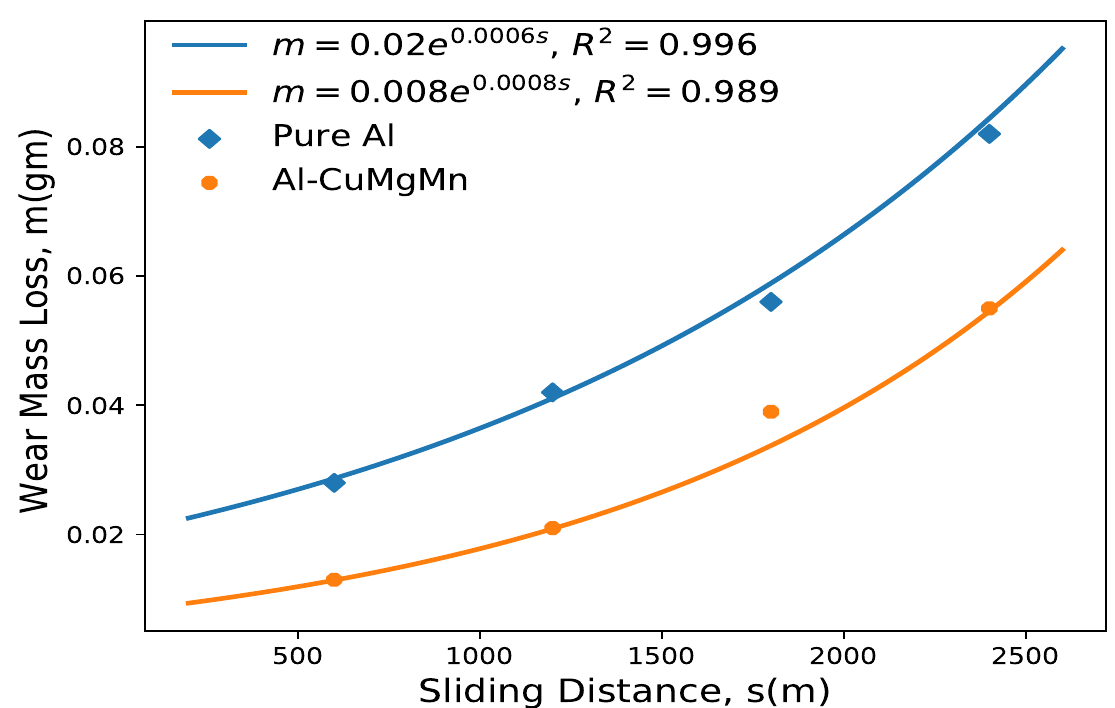
Figure 11. Effect of sliding distance and normal load on wear mass loss for samples processed by laser power 1700 W at 20 N